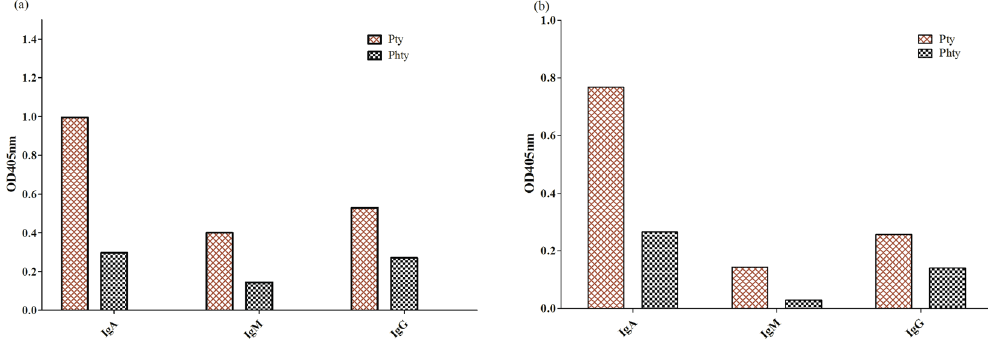
Figure 2. Validation of of rHlyE epitopes. Immunoassay of ( a ) linear rHlyE epitope and ( b ) conformational rHlyE epitope against Pty sera with Phty sera as negative control. The experiment was performed with duplicates.